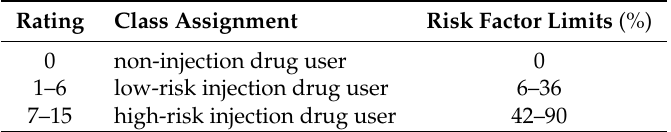
Table 3. Complementary table displaying and quantifying injection drug user risk associated behaviors. Each rate value (0–5) is equal to % risk factor value. (i.e., rating value of 7 = 42% risk